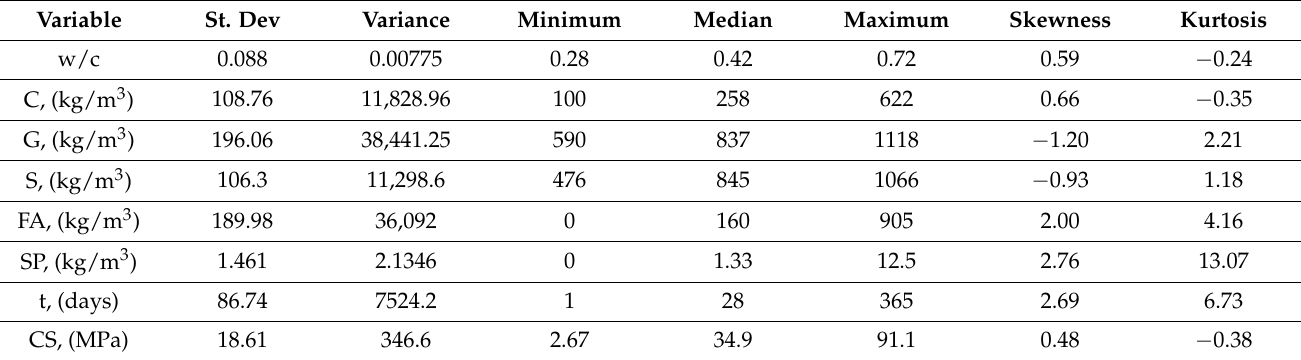
Table 2. The statistical analysis of the collected datasets.